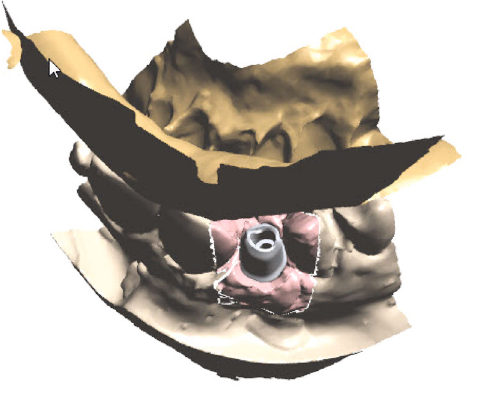
Figure 14: Design of the abutment/crown construction using 3Shape Dental Manager. Plaster model with the stationary scanner D2000 (3Shape, Trios). Antagonistic